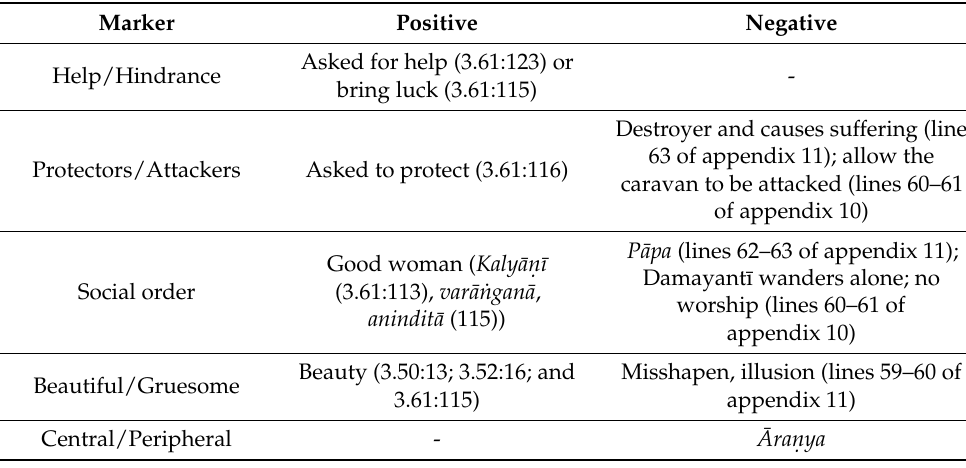
Table 1. Evaluation of the yaks.a in the story of Nala and Damayant¯ı.